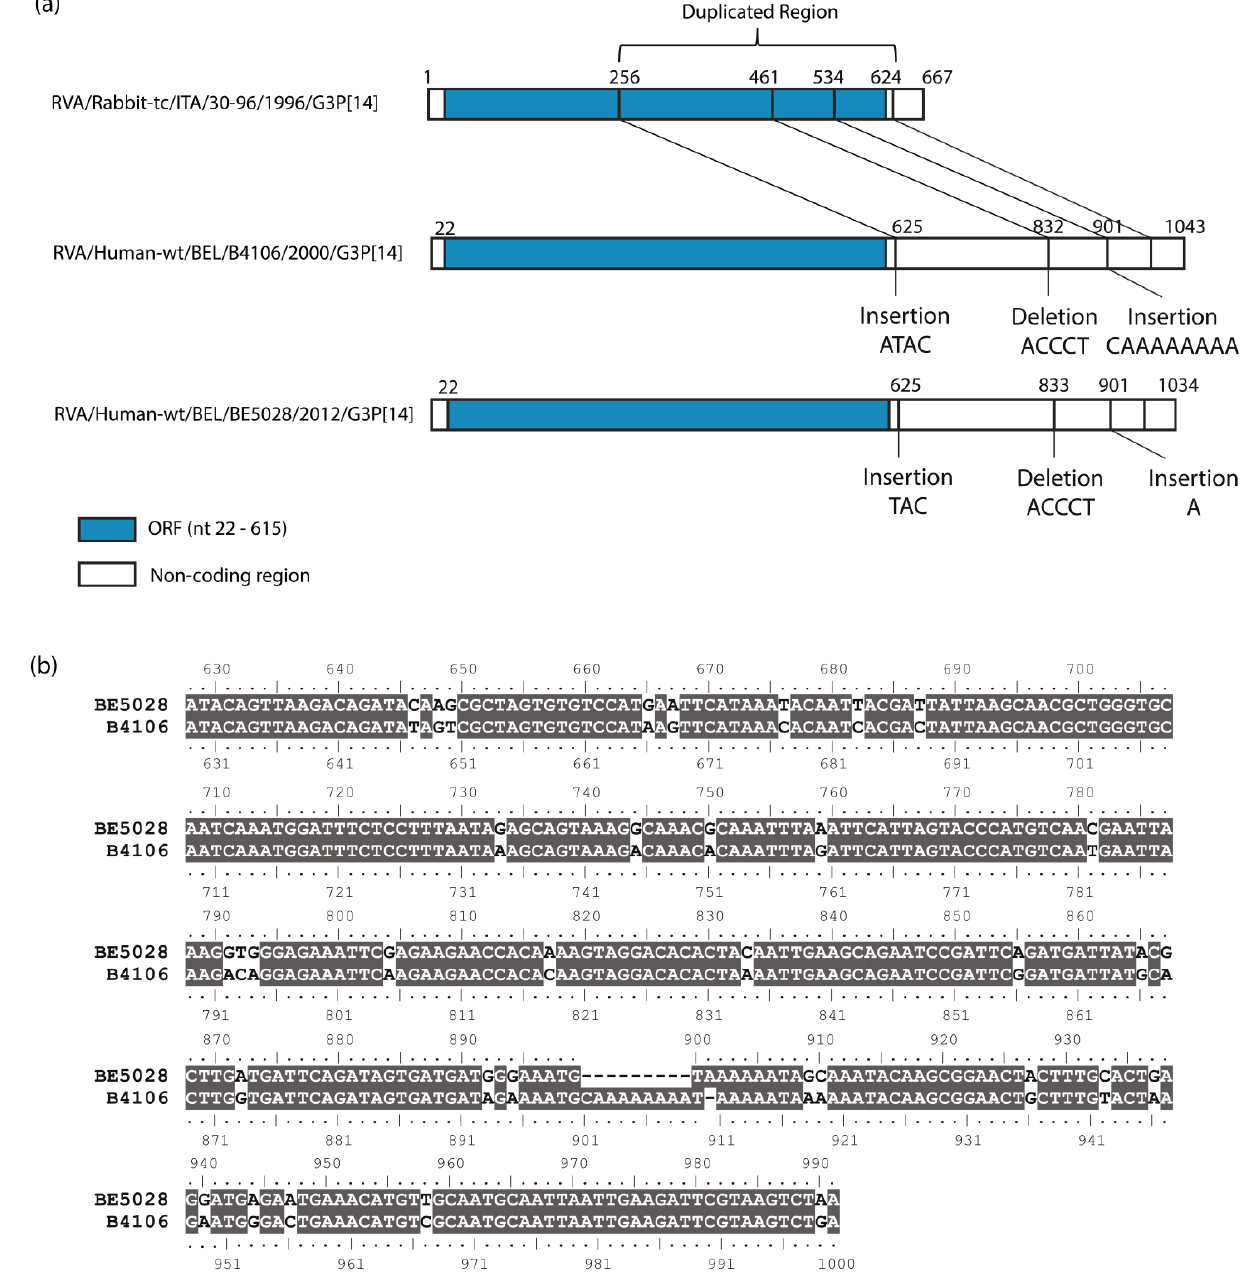
Figure 2. ( a ) A schematic representation of the rearrangements found in the duplicated region of the NSP5 of BE5028, compared to the NSP5 sequence of 30–96 and to the duplicated region of the NSP5 of B4106. The blue region indicates the ORF of NSP5; ( b ) Sequence alignment of the duplicated sequence of BE5028 and B4106 NSP5. Identical residues are shown in